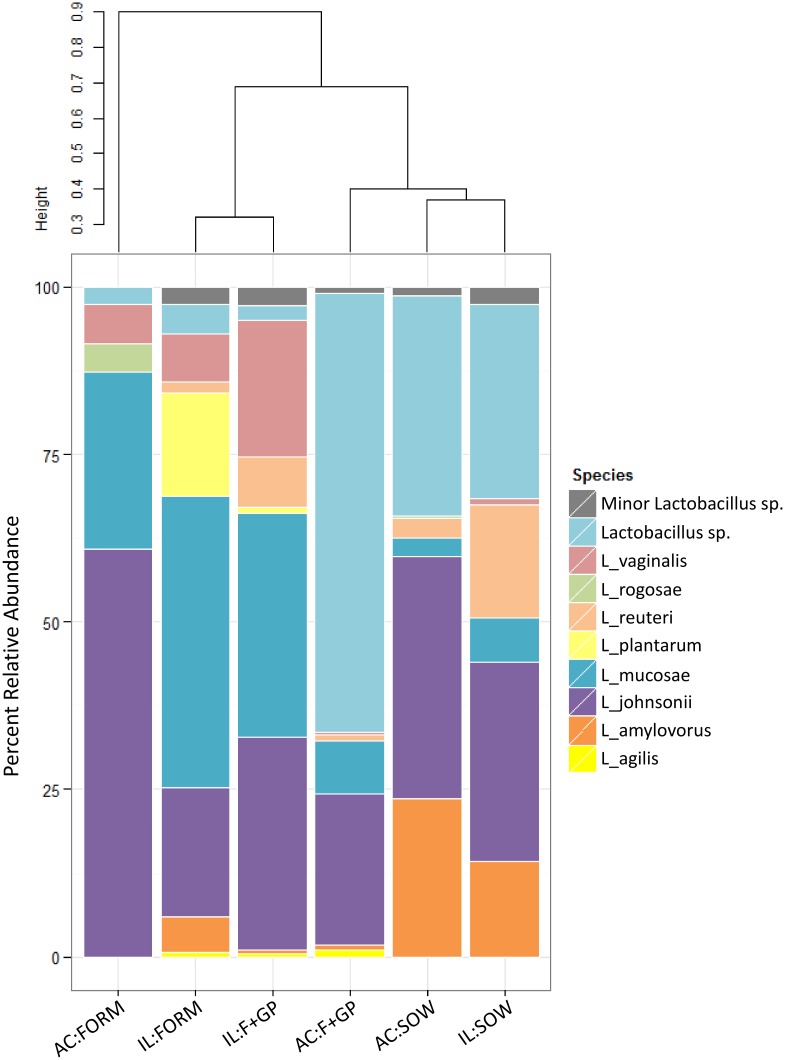
Culture-independent analysis reveals a more diverse lactobacilli community.Lactobacilli communities from the ileum (IL) and ascending colon (AC) of 21 d old piglets fed either a bovine milk-based formula (FORM), formula supplemented with GOS and PDX (F+GP) or sow-reared (SOW) as determined by 16S amplicon sequencing. Stacked bar chart represents the percent relative abundance of each lactobacilli detected in the community. Beta diversity was calculated using the Bray-Curtis Dissimilarity Index and is visualized by a dendrogram. Lactobacilli represented by the label Lactobacillus sp. were unable to be assigned a species. Minor Lactobacillus sp. is an aggregate of lactobacilli present in > 1% percent relative abundance (S3 Table).